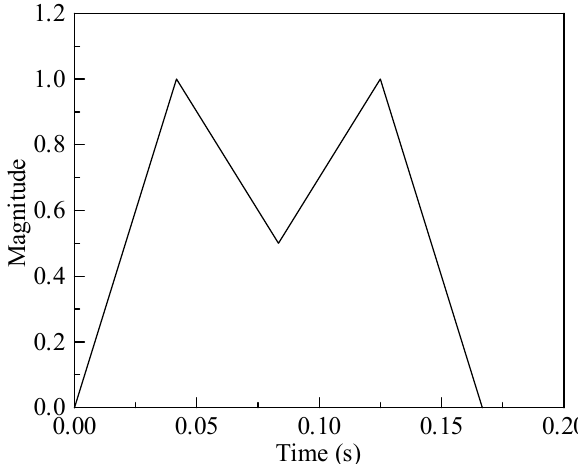
Figure 9. Amplitude–time curve of the “M” type load.